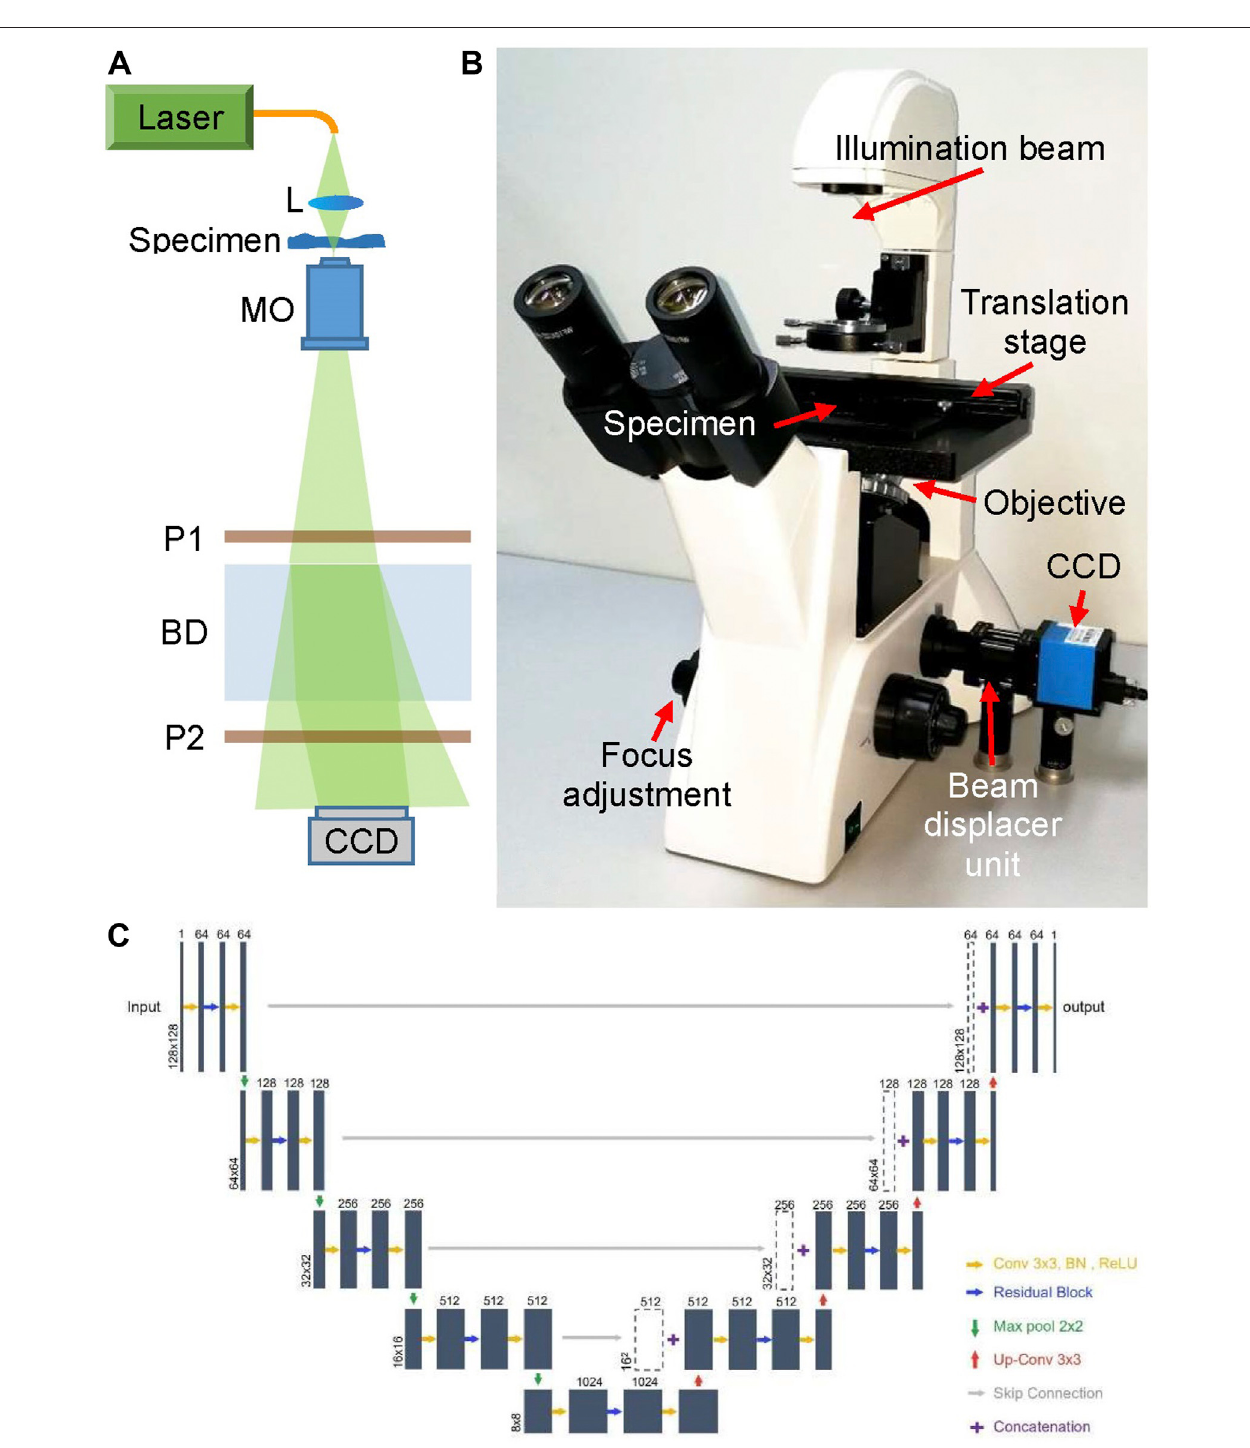
FIGURE 1 | Deep learning-based holographic microscope and PhaseNet architecture. (A) Optical schematic of the common-path digital holographic microscope based on a beam displacer unit; (B) deep learning-based holographic microscope; (C) . Detailed schematic of PhaseNet architecture. Each blue box corresponds to a multi-channelfeaturemap.Thenumberofchannelsisprovidedontopofthebox.The x – y -sizeisdenotedatthelowerleftedgeofthebox.Whiteboxesrepresentcopied feature maps.